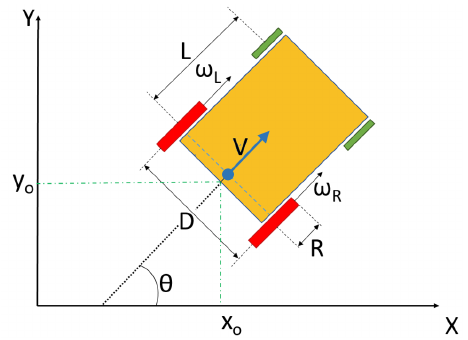
Figure 15. Cinematic model of a